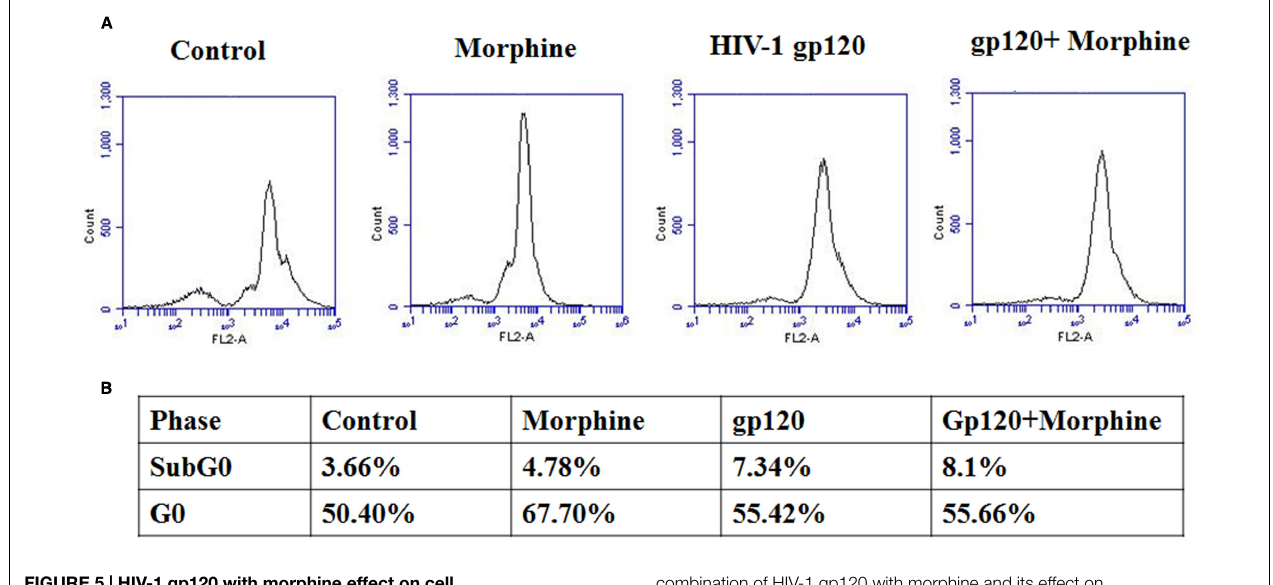
FIGURE 5 | HIV-1 gp120 with morphine effect on cell cycle progression. Microglia (1 (cid:2) 10 6 cells/ml) were treated with HIV-1 gp120 (100 ng), morphine (0.5 µ M) and